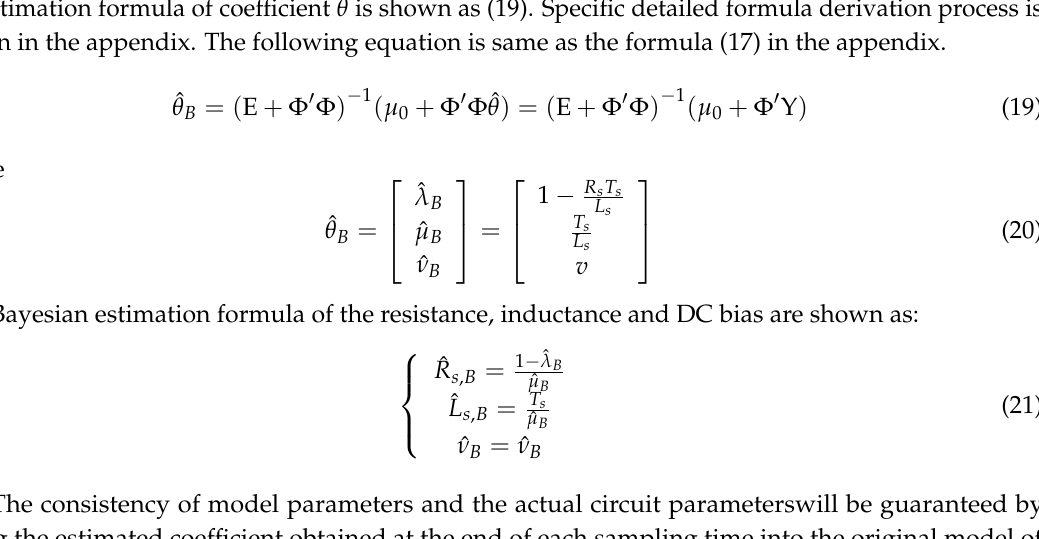
Figure 4. The histogram of the inductance value ( a ) and probability density distribution function ( b ). According to the above analysis, the priority distribution function of the estimation parameters can be expressed by the Gaussian function. Based on Bayesian estimation theory in Reference [30], the estimation formula of coefficient is shown as (19). Specific detailed formula derivation